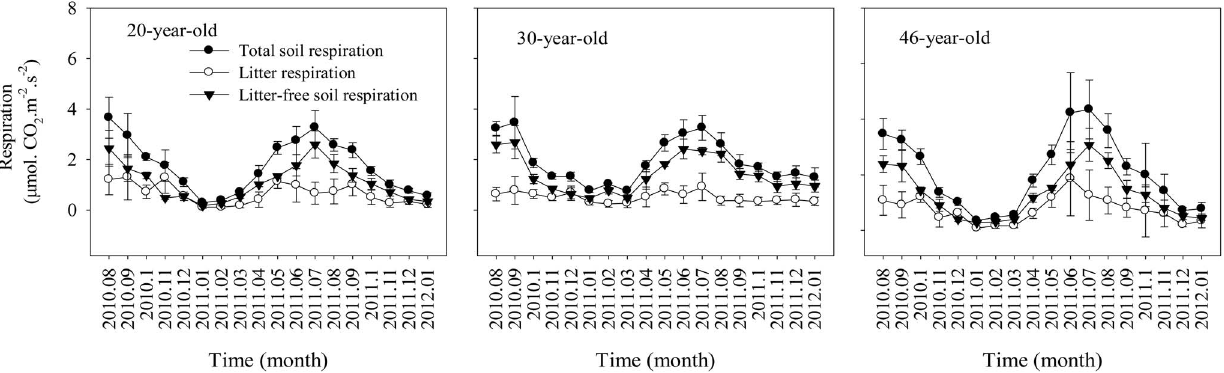
Figure 1. Seasonal patterns and monthly dynamics of the total soil respiration ( N ), litter respiration ( # ), and the litter-free soil respiration ( . ) in different-aged Pinusmassoniana forests (mean ± 1SD, n